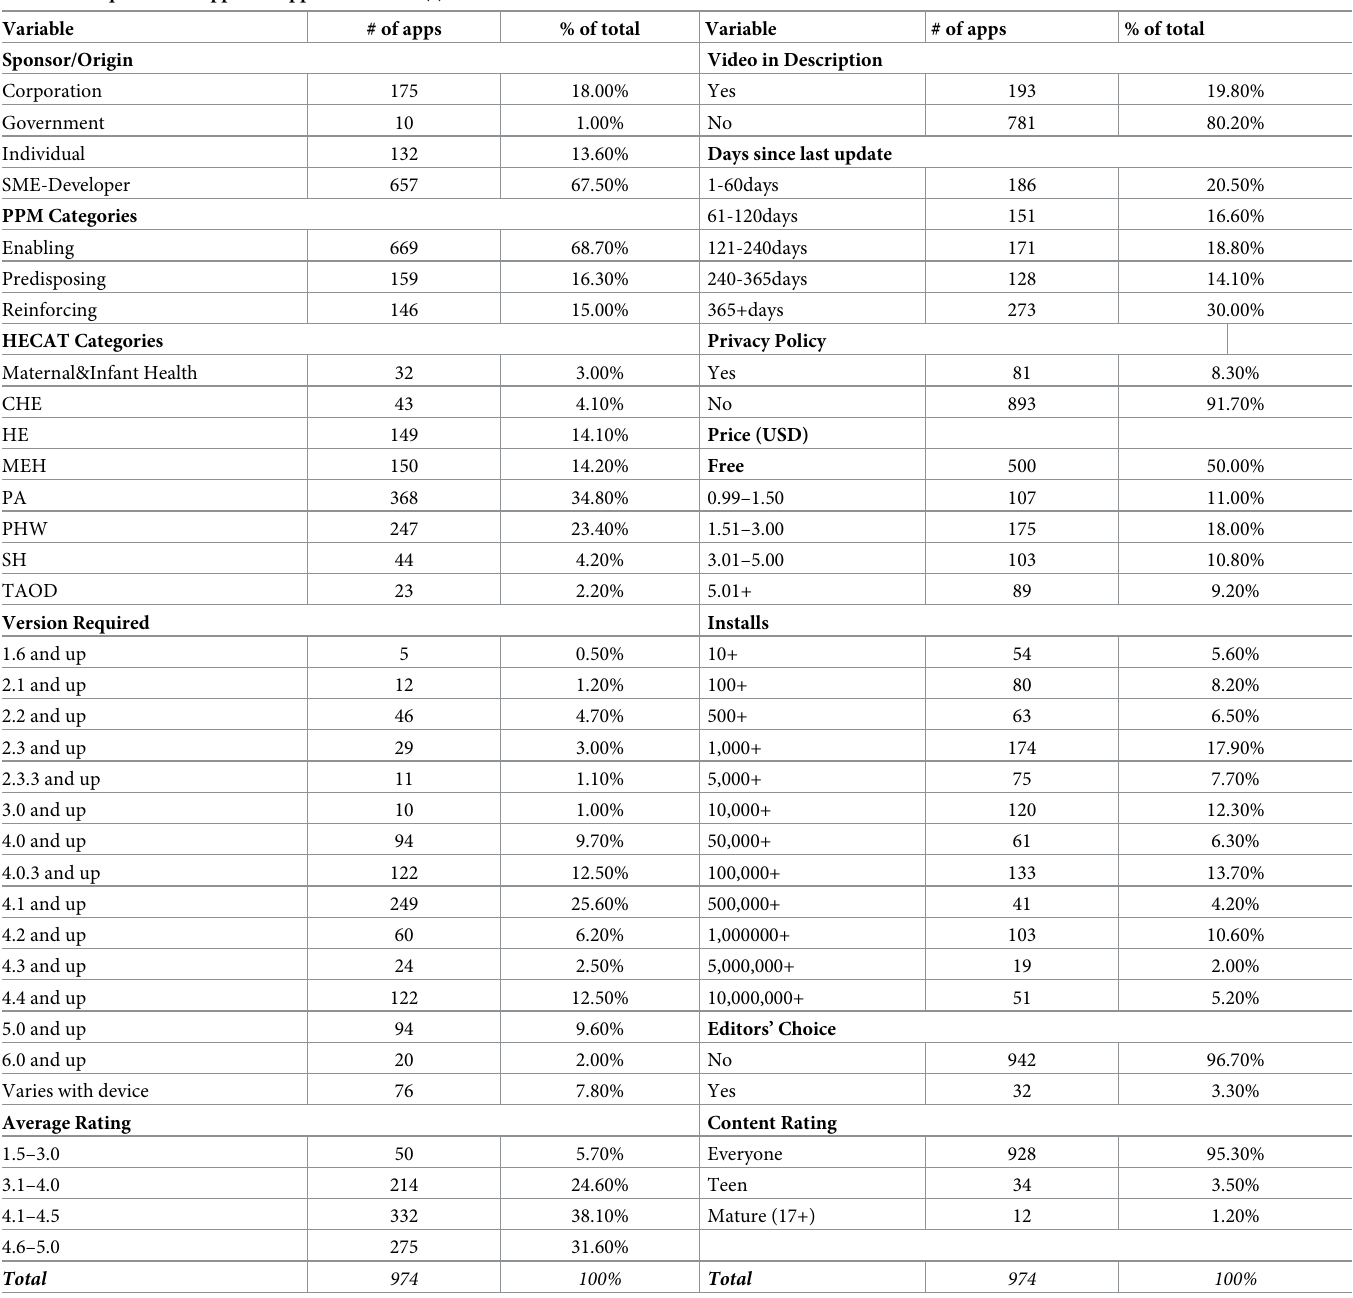
Table 2. Frequencies of apps and app